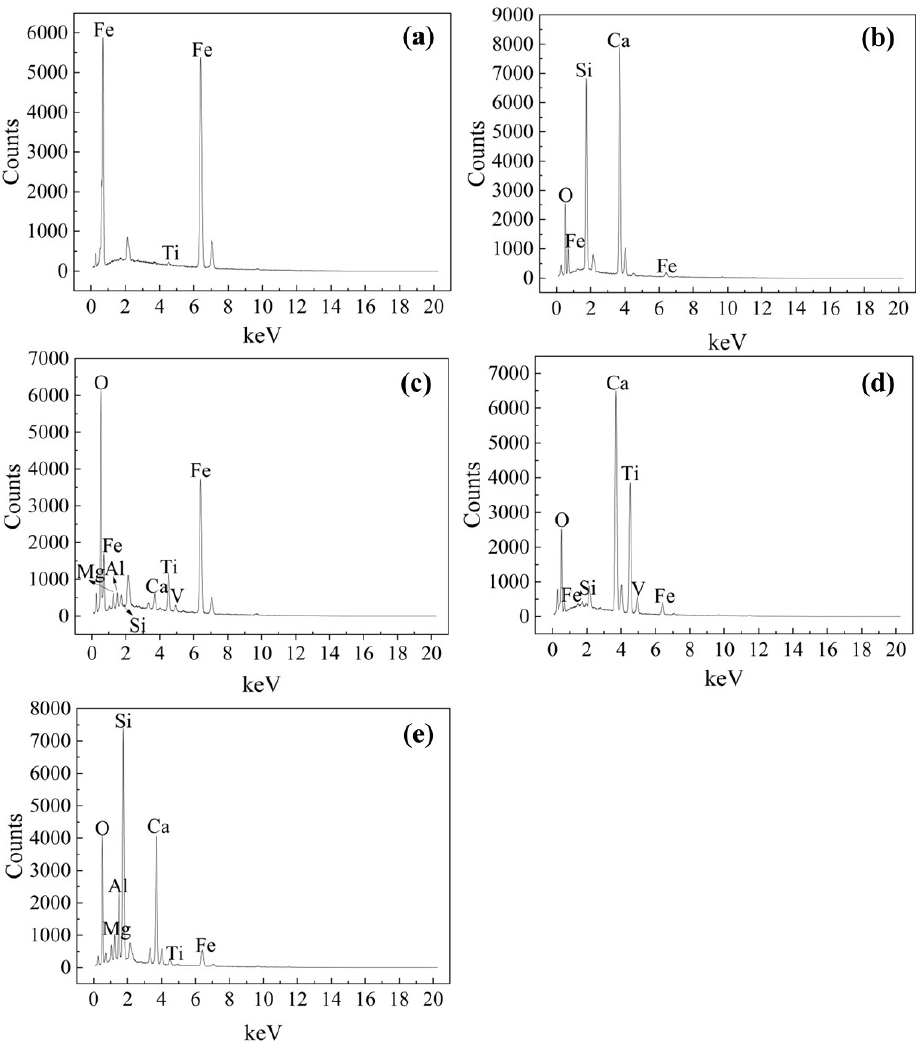
Figure 13. Energy disperse spectroscopy (EDS) analyses of different points: ( a ) point A; ( b ) point B; ( c ) point C; ( d ) point D; ( e ) point E.